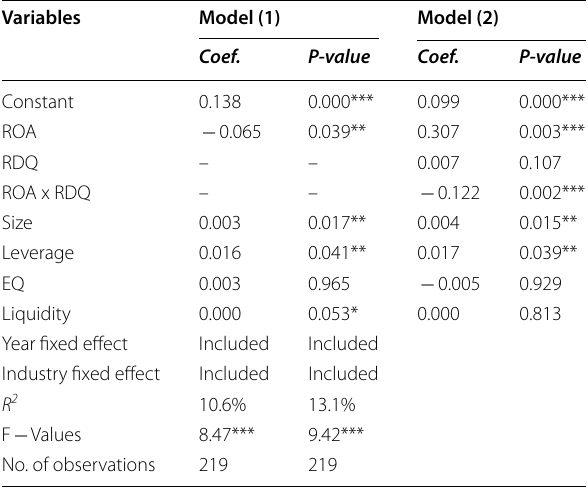
Table 7 Regression models using cost of equity in the following year